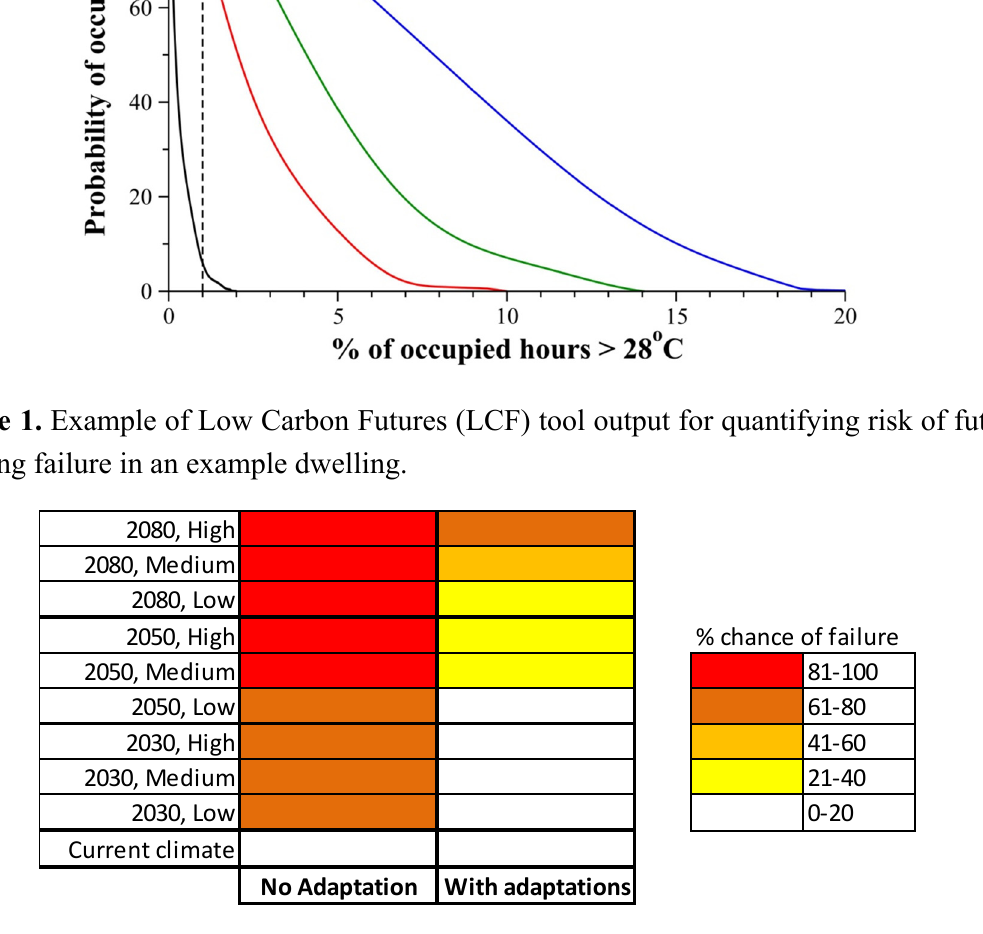
Figure 2. Simplified risk matrix from LCF tool for quantifying risk of future building failure in an example